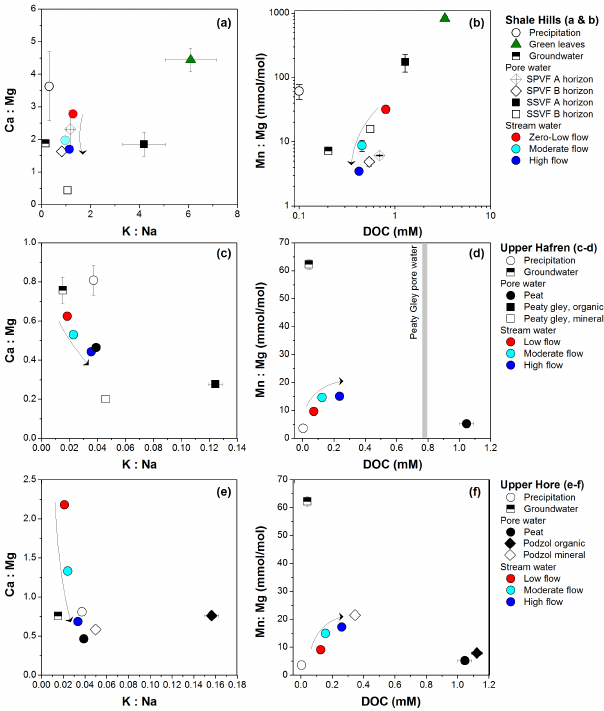
Figure 3. Molar ratios of major divalent (Ca:Mg) versus univalent (K:Na) cations are plotted on the left and the molar ratios of Mn (mmol) to Mg (mol) versus dissolved organic carbon (mmolL − 1 ) are plotted on the right for solute source pools in the forested Shale Hills (a, b) , peatland Upper Hafren (c, d) , and predominately forested Upper Hore (e, f) catchments. Arrows indicate direction of increasing discharge for average stream chemistries. Values for to- tal C ( ∼ 33mmolkg − 1 ) and K:Na ( ∼ 60) in leaves are divided by 10 to fit on plots (a) and (b) . For soil pore water, filled symbols in- dicate organic-rich waters and open symbols indicate organic-poor